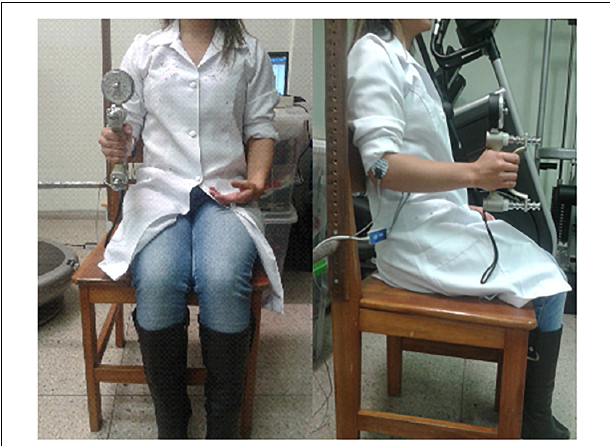
FIGURE 2 | Positioning during the handgrip strength measure with simultaneous electromyography registry of the flexor digitorum superficialis muscle of the dominant hand.